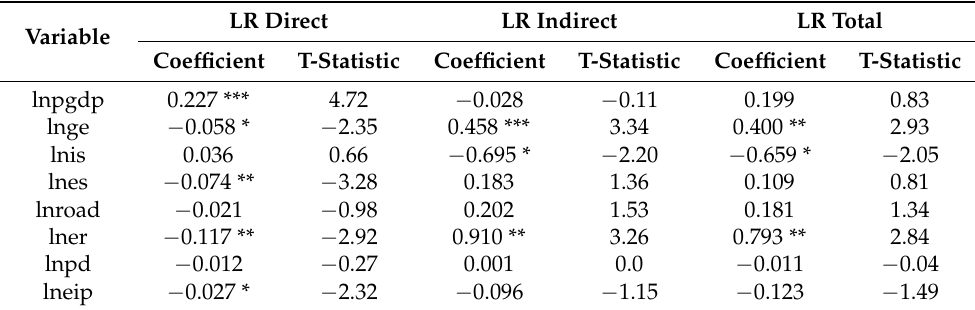
Table 8. Robustness test results after spatial weight matrix